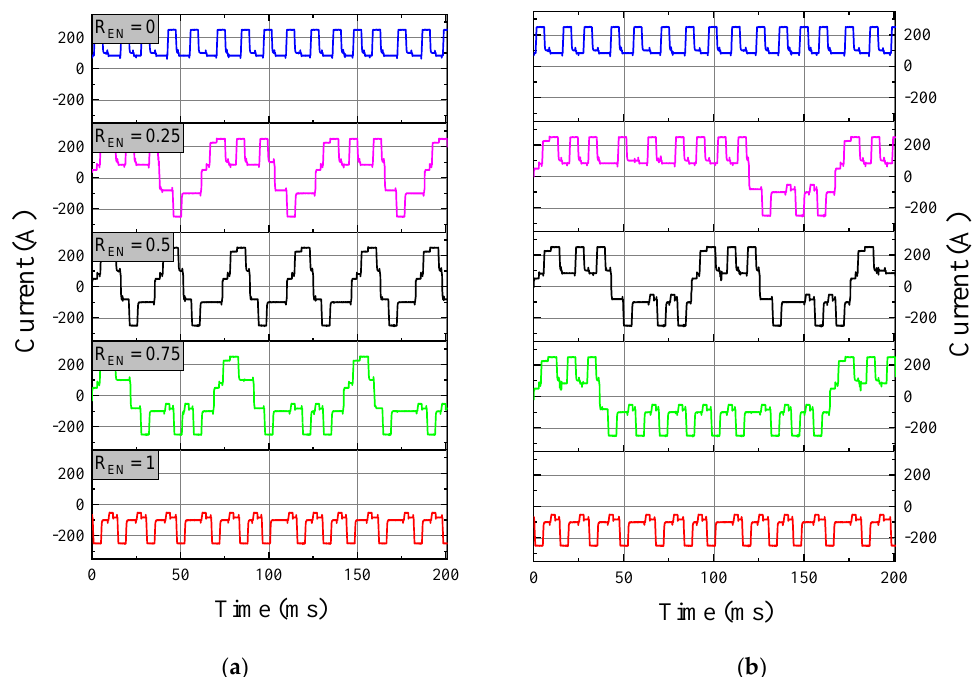
Figure 6. Current waveforms acquired under the conditions of ( a ) one and ( b ) three pulse repetitions at welding speed of 0.7 m/min.